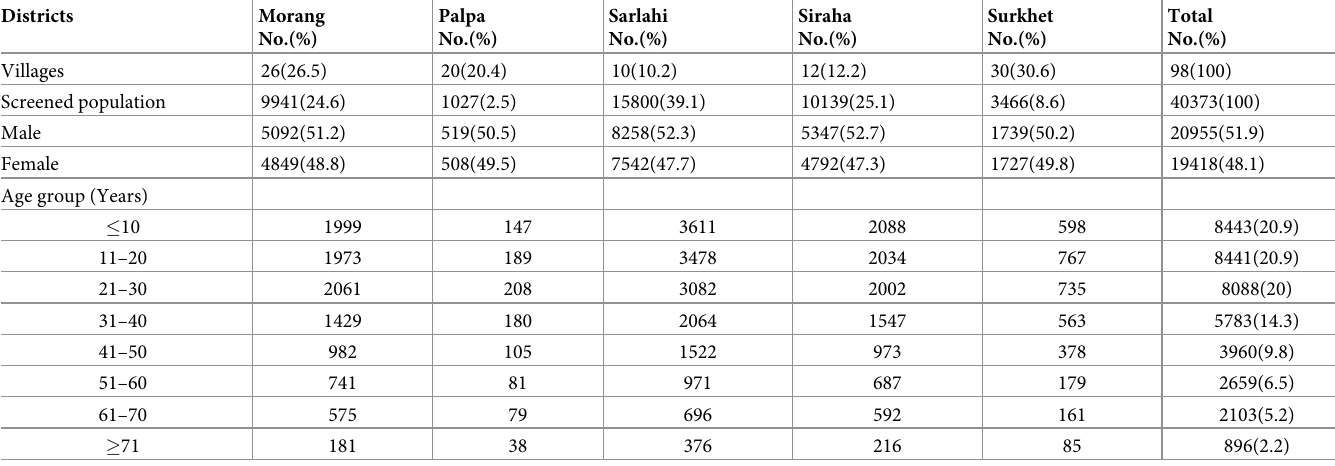
Table 1. Characteristics of screened population in five